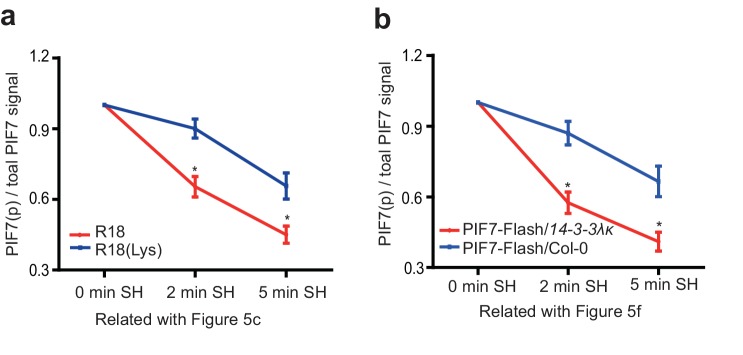
Quantification of phosphorylated PIF7(PIF7[p]) relative to total PIF7 proteins in Figure 5c and f.(a) Quantification of R18 and R18(Lys) treatment in Figure 5c. (b) Quantification of PIF7-Flash/14-3-3λκ and PIF7-Flash/Col-0 background in Figure 5f. The intensities of phosphorylated PIF7 (top) and total PIF7 proteins were measured using Image J (http://rsb.info.nih.gov/ij/). The original images were converted to 8-bit format and then inverted so the background was dark and the bands were white. The signal intensity was integrated from all pixels in the selected area. The intensities of top bands were measured as phosphorylated PIF7 and the intensities of all bands as total PIF7 proteins. The ratios of phosphorylated PIF7 relative to total PIF7 proteins were calculated. The ratio at 0 min SH was set artificially as 1.0, and the ratio at 2 min SH/5 min SH were normalized to it. Quantitative data in (a) and (b) are shown as means ± SE, n = 3.